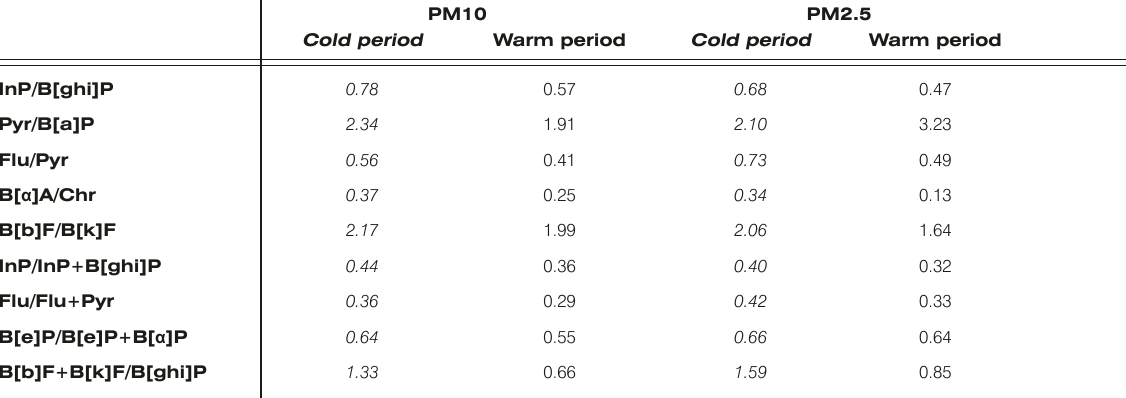
Table 3. Diagnostic ratios of PM10 and PM2.5-bound PAHs concentration.